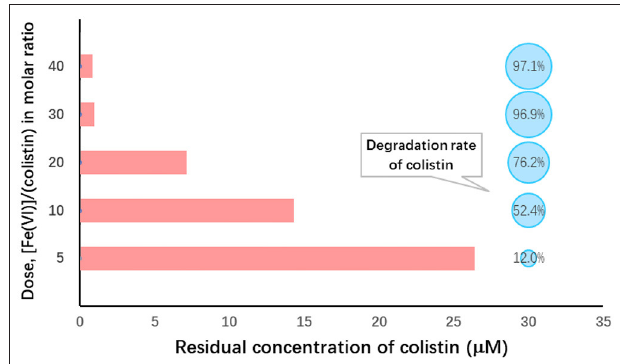
FIGURE 1 | Ferrate (VI): colistin molar ratio dependence on colistin removal from solution. Initial colistin concentration, 30 µ M; [Fe(VI)]/(colistin) molar ratio, 5–40; initial pH 9.0; temperature, 25 ◦ C; reaction duration, 60 min.